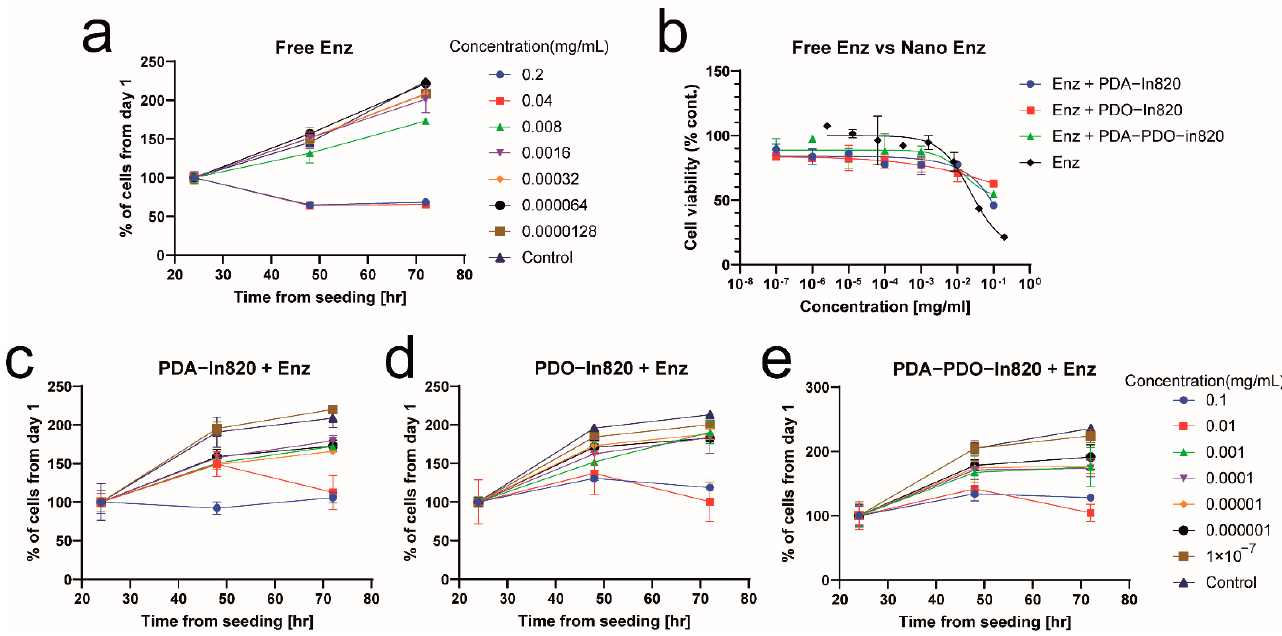
Figure 8. In vitro toxicity assay of enzalutamide nanoparticles in mouse embryonic fibroblasts, 3T3 cells. ( a ) Image-based cell counting at various times of incubation with free enzalutamide. ( b ) MTT viability assay after 3 days of incubation with free enzalutamide and its nanoparticles. ( c – e ) Image- based cell counting at various times of incubation with the different enzalutamide nanoparticles.